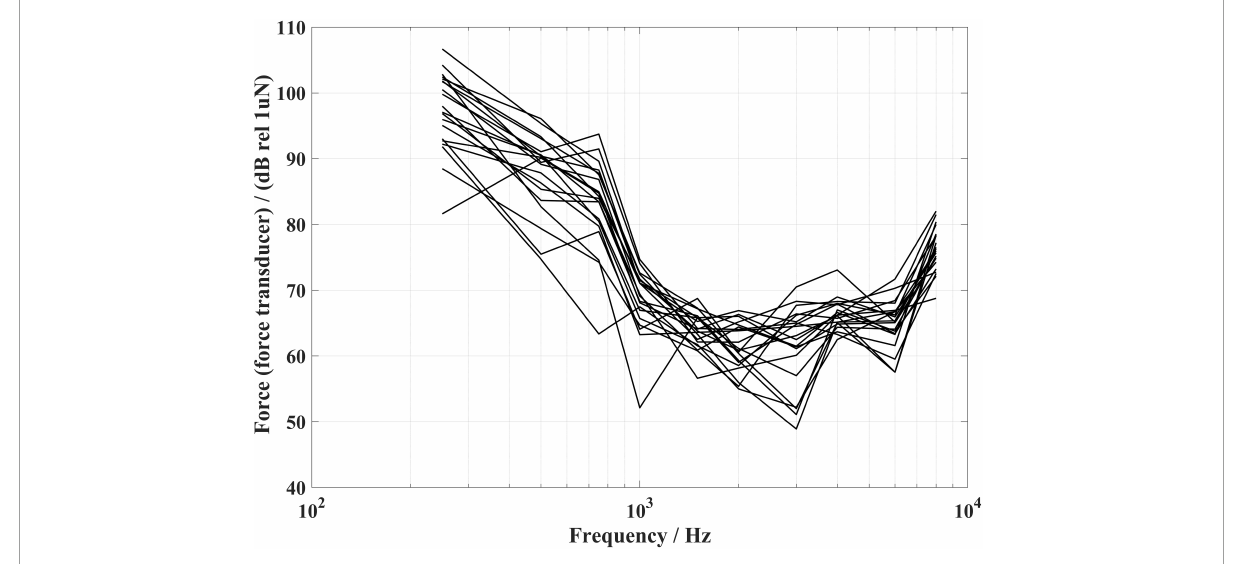
FIGURE13 The FL_FT corresponding to a fixed 30 dB HL bone conduction (BC) at each frequency for the 20